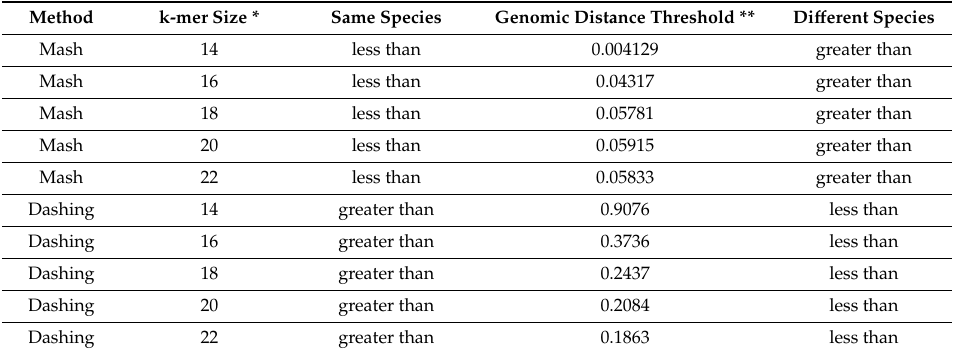
Figure 5. Pairwise genomic distances between all genomes of various genera, calculated by Dashing with k-mer size 16. Distances are shown as box-and-whiskers plots, with outliers marked as dots and mean distances per genus marked with crosses. The solid vertical line shows the threshold distance between the ranks, calculated to minimize the share of genomic distances on the wrong side of the line (misclassified distances). Only genera with at least 20 pairwise distances are shown. Table 2. Threshold genomic distances between fungal species and genera for di ff erent k-mer sizes calculated with Mash and Dashing programs; commands for calculating the distances are listed in Table